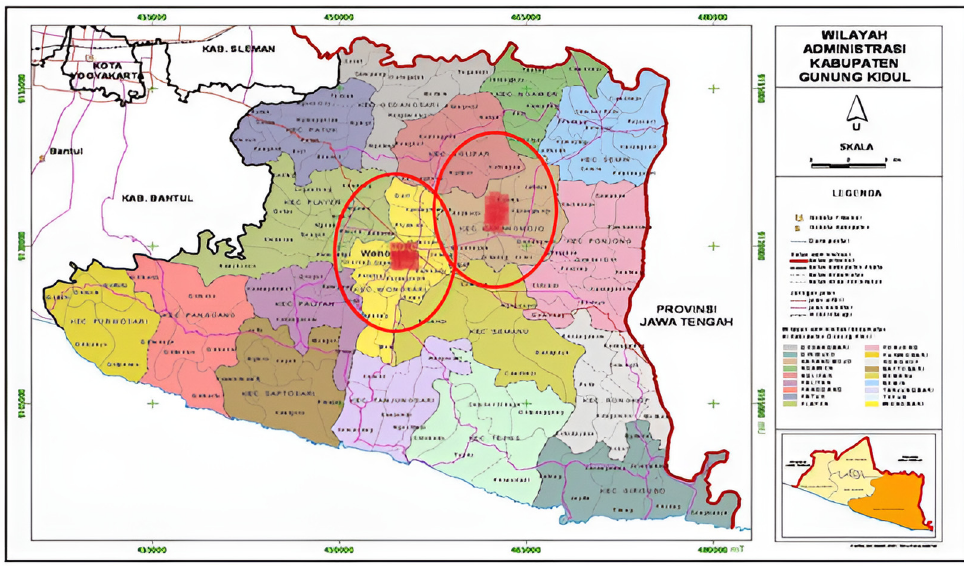
Figure 2. Wonosari and Karangmojo Sub-District, Gunungkidul Regency, Yogyakarta. (Data from: Peta Kota [27]).